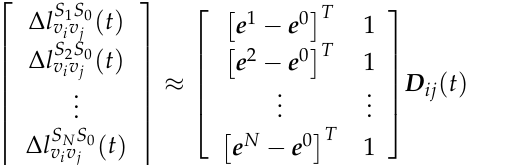
( c ) Figure 9. Experiment equipment: ( a ) Unmanned ground vehicle; ( b ) Passenger car ; ( c ) Base sta- tion. 4.2. Static Experiments. The static experiments were conducted in the parking lot of Southeast University, Nanjing. Six scenarios were tested, i.e., with the vehicle distances of 5 m, 10 m, 15 m, 25 m, 35 m and 50 m. Each scenario was tested for 15 min, and the IVD was measured online. In addition, the two vehicle platforms could observe the same GPS satellites. To evaluate the performance of different estimation methods quantitatively, the root means square error ( RMSE ) is proposed.